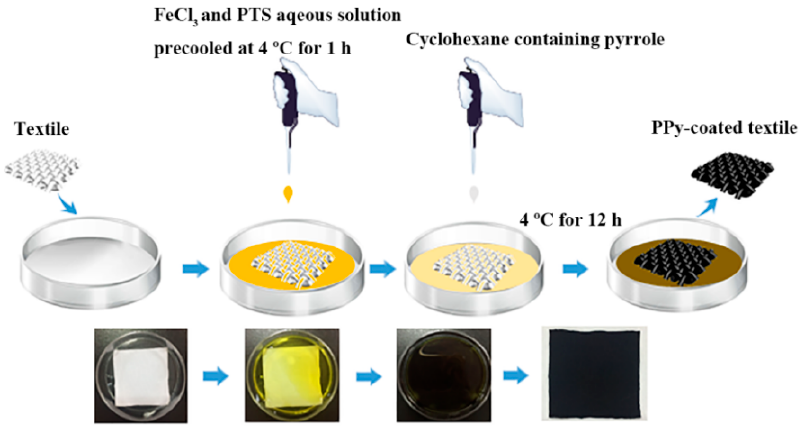
Figure1. Figure 1. Preparation of polypyrrole (PPy)-coated textile via low-temperature interfacial polymerization.